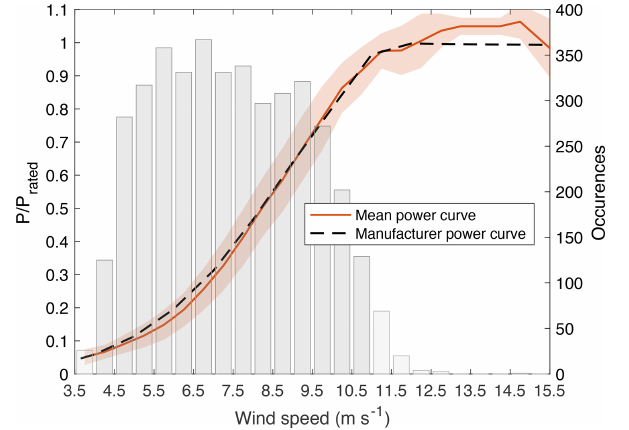
Figure 6. Mean power curve for Turbine C based on 80m lidar wind speed measurements overlaying the number of power produc- tion cases for each 0.5ms − 1 wind speed bin. The shaded region in the power curve corresponds to ± 1SD (standard deviation), and the dark grey histogram corresponds to the wind speed ranges consid- ered in this